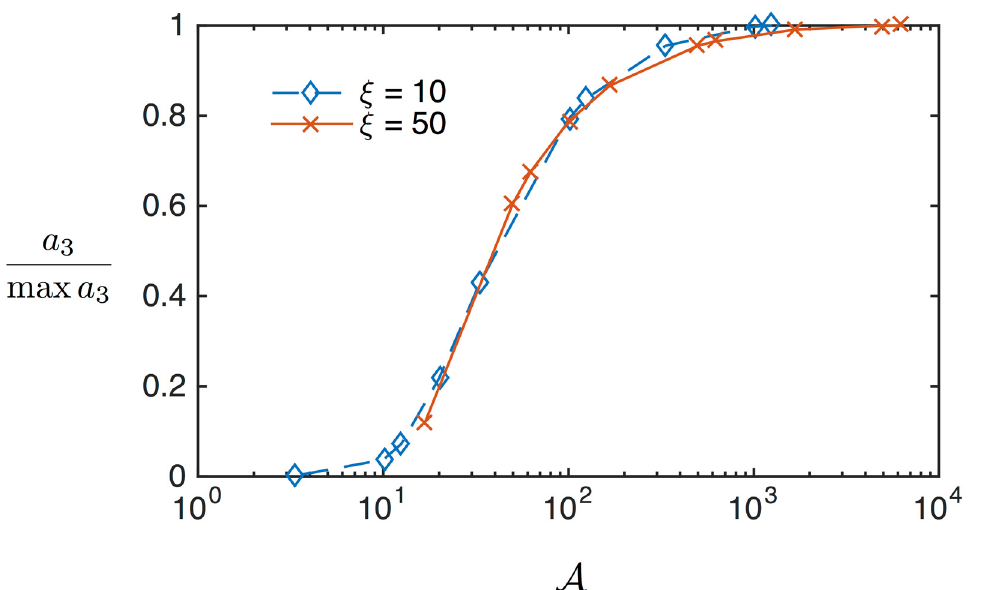
Fig 3. (Color online) Scaling relationships in the magnetization harmonics are simulated by varying the mean relaxation time and plotting against the master variable. The normalized third harmonic is equivalent for two values of the unitless field.